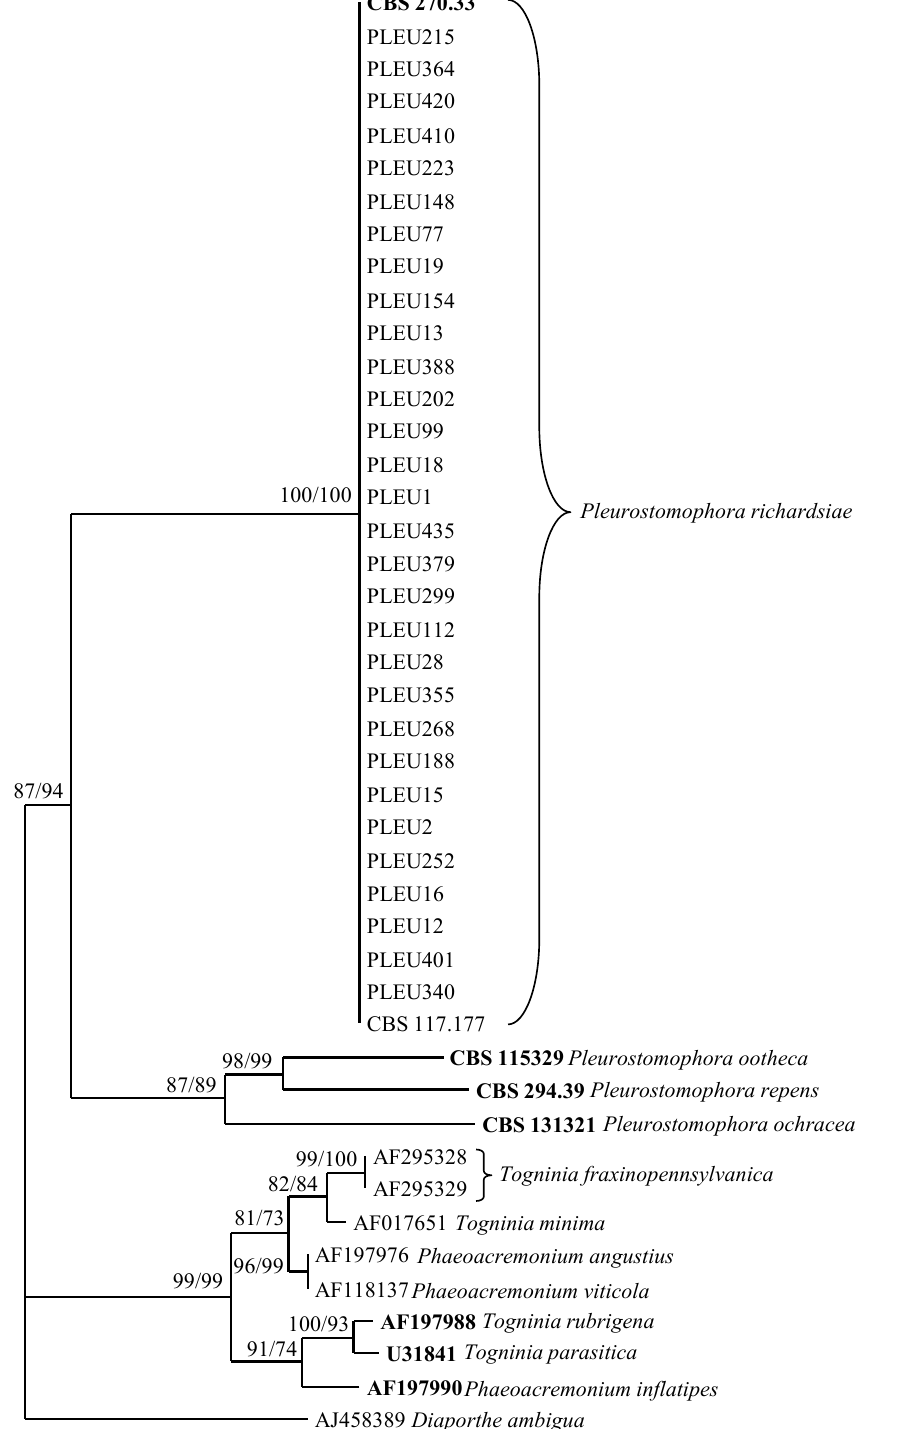
Figure 3. One of the most parsimonious trees obtained from alignment of the ITS sequence data with bootstrap support values valid for NJ/MP. Ex-type isolates are in bold face. Diaporthe ambigua was used as an